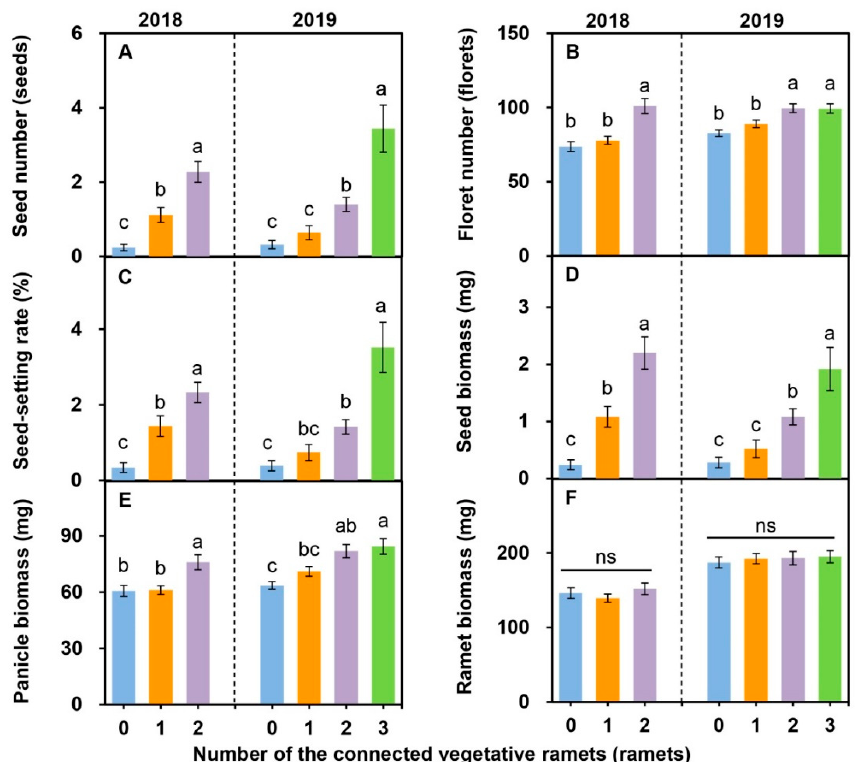
Figure 1. E ff ects of the number of vegetative ramets connected to tillering nodes on sexual reproductive characteristics (seed number, ( A ); floret number, ( B ); seed-setting rate, ( C ); seed biomass, ( D ); panicle biomass, ( E ); ramet biomass, ( F )) in the natural populations of Hierochloe glabra over two consecutive years (data are represented as the means ± standard errors, n = 25). Di ff erent lowercase letters indicate significant di ff erences among di ff erent numbers of vegetative ramets ( p < 0.05); ns represents that there is no significant di ff erence between di ff erent numbers of connecting vegetative ramets ( p >